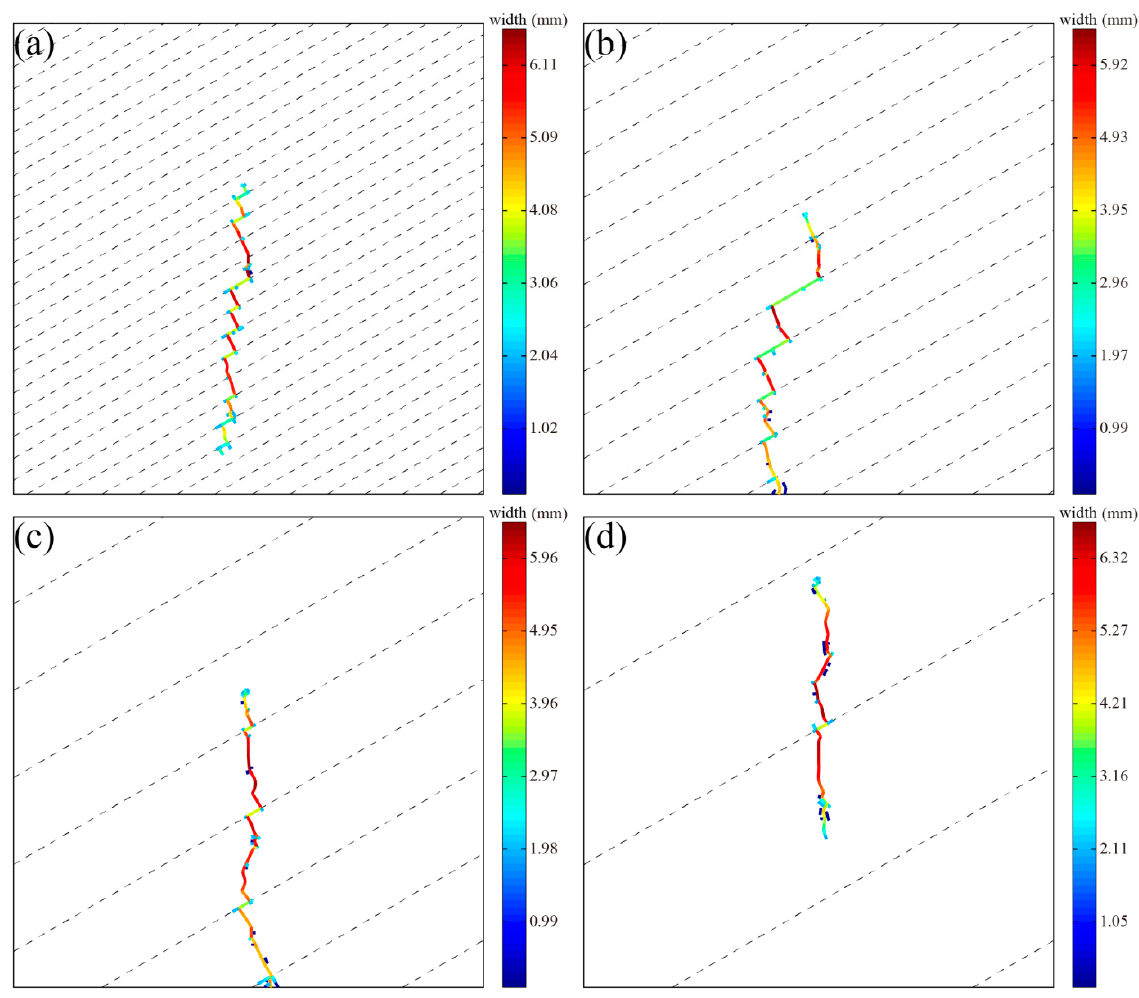
Figure 13. Fracture paths under different bedding spacing. The bedding spacing of ( a – d ) are 2 m,